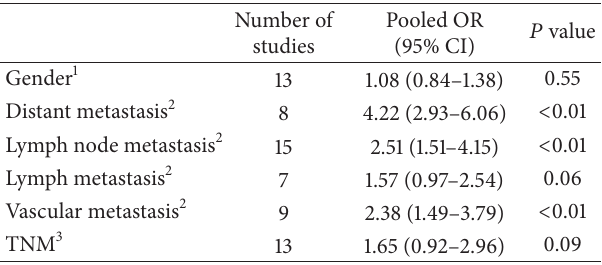
Table 2: Pooled ORs for the association between VEGF expression and clinical and pathology features.